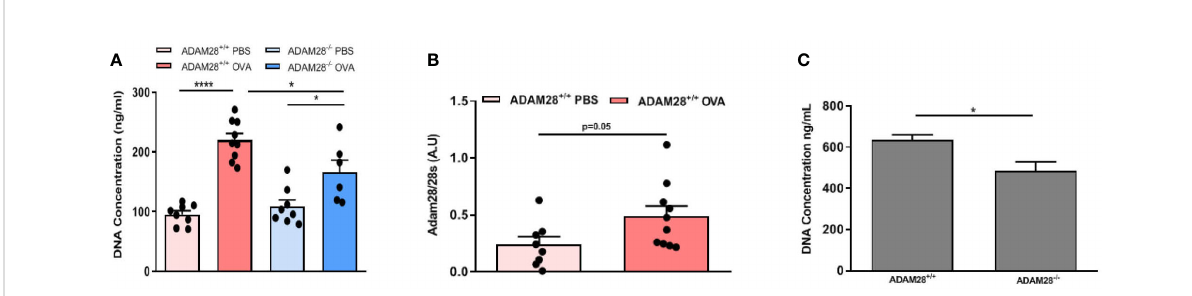
FIGURE 6 Study of lung fi broblasts. (A) CyQuant measurement of cell proliferation of fi broblasts extracted from lungs of ADAM28 -/- and ADAM28 +/+ mice exposed to OVA or PBS. DNA levels were measured in cell culture during 48h (N=2; ADAM28 +/+ - PBS n=8, ADAM28 +/+ - OVA n=9, ADAM28 -/ – PBS n=8, ADAM28 -/ – OVA n=6). (B) RT-PCR measurement of ADAM28 mRNA expression in fi broblasts extracted from wild-type mice exposed to OVA or PBS for 90 days (N=2; ADAM28 +/+ - PBS n=8, ADAM28 +/+ - OVA n=10). (C) Measurement by CyQuant of cell proliferation of fi broblasts extracted from lungs of naive mice exposed during 48 hours to media enriched with 10% of BALF from ADAM28 +/+ or ADAM28 -/- mice exposed to OVA in the LT model. DNA levels were measured in cell culture during 48h (N=1; ADAM28 +/+ - OVA n=7, ADAM28 -/ – OVA n=7). Results are represented as the mean ± SE. *p<0.05, ***p<0.001 (Figure 6A: One way ANOVA, Figures 6B, C: